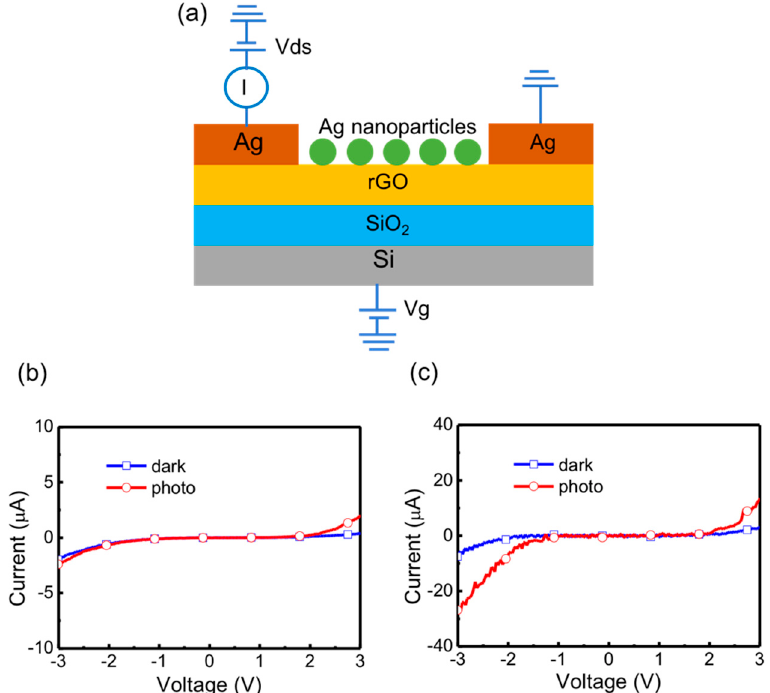
Figure 6. ( a ) Cross-sectional view of the rGO photosensor with electrical connections for